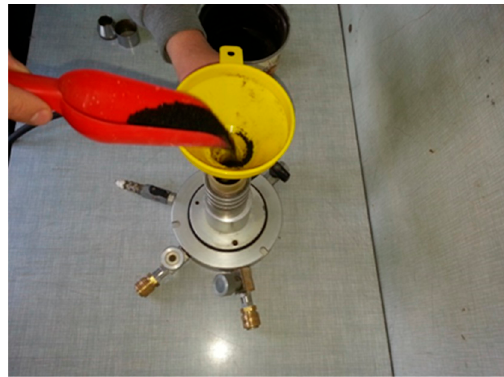
Figure 3. Preparation of specimens from the pure powder or granulate.